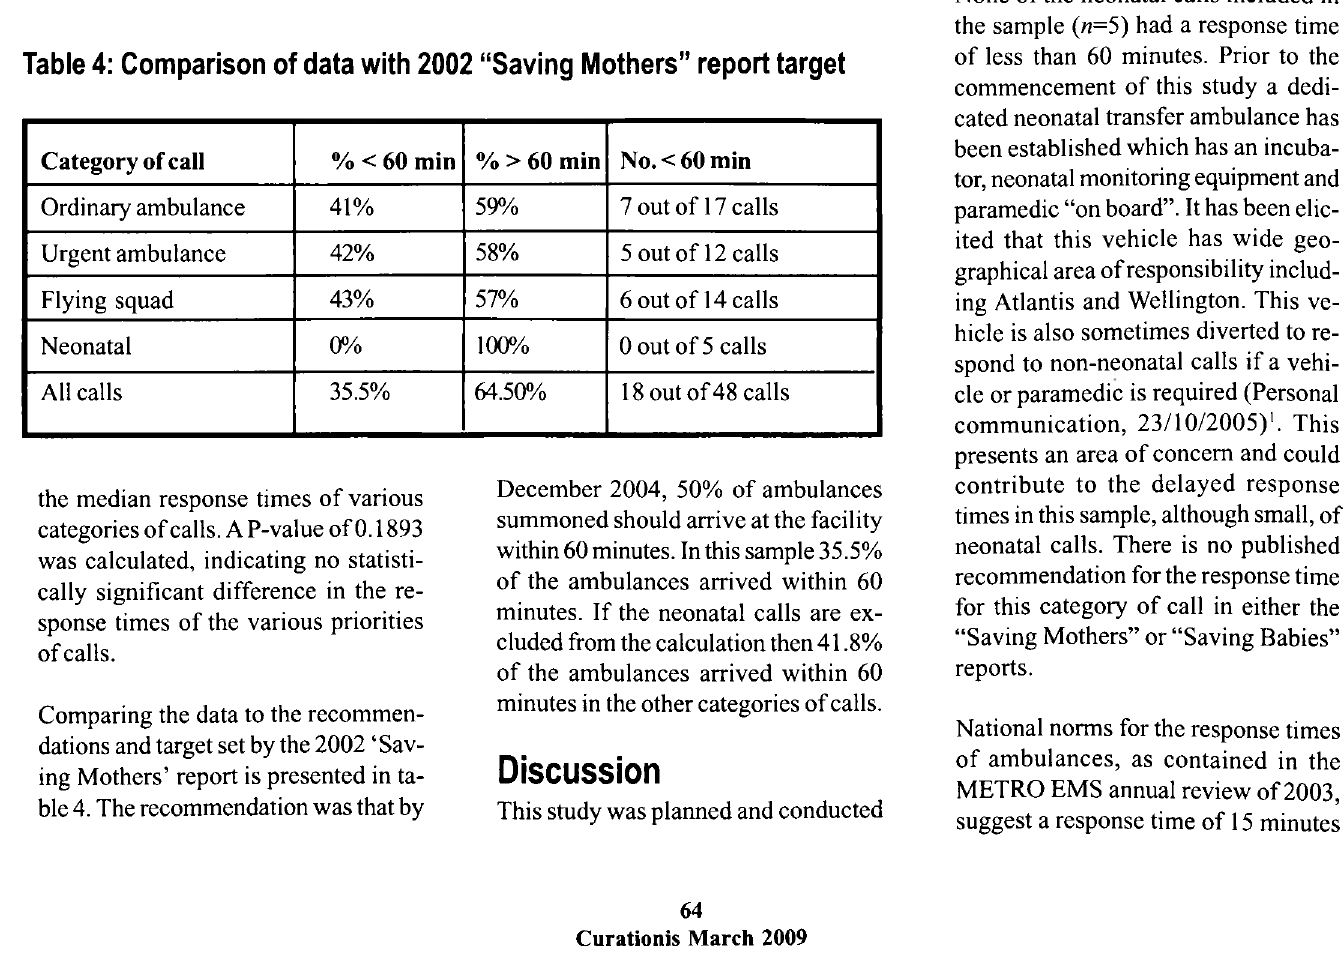
Table 4: Comparison of data with 2002 “Saving Mothers” report target